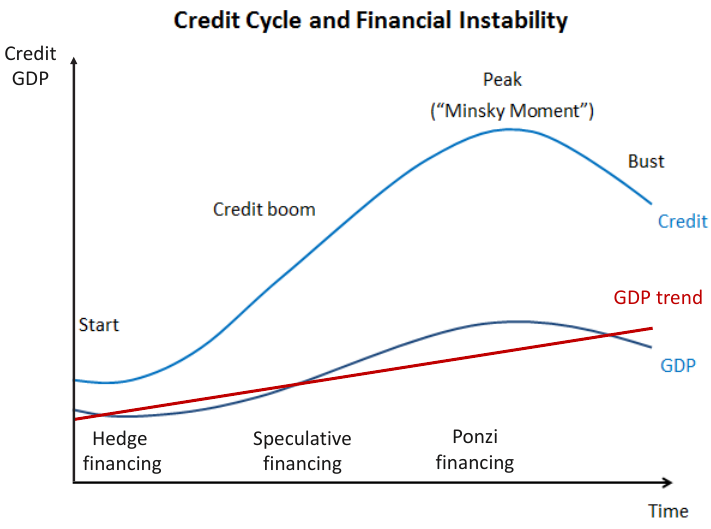
Figure 1. Credit cycle during financial instability